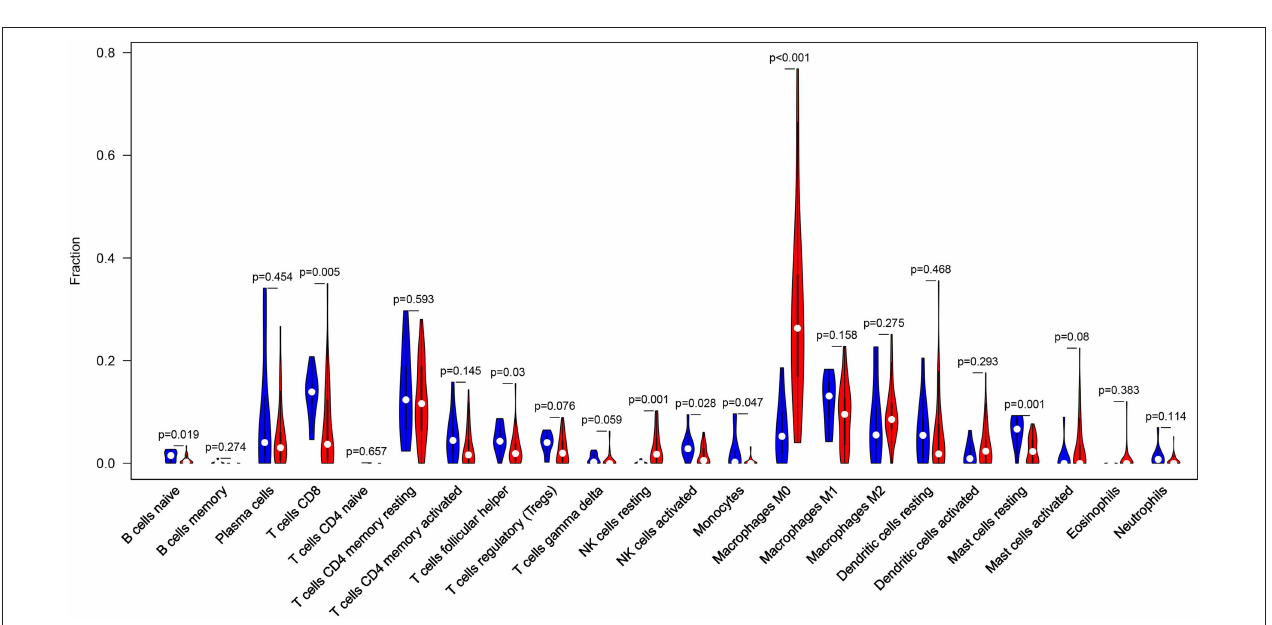
FIGURE 3 | The Violin plot exhibits the difference between CIBERSOFT immune cell fractions between HNC adjacent tissues and tumor tissues.